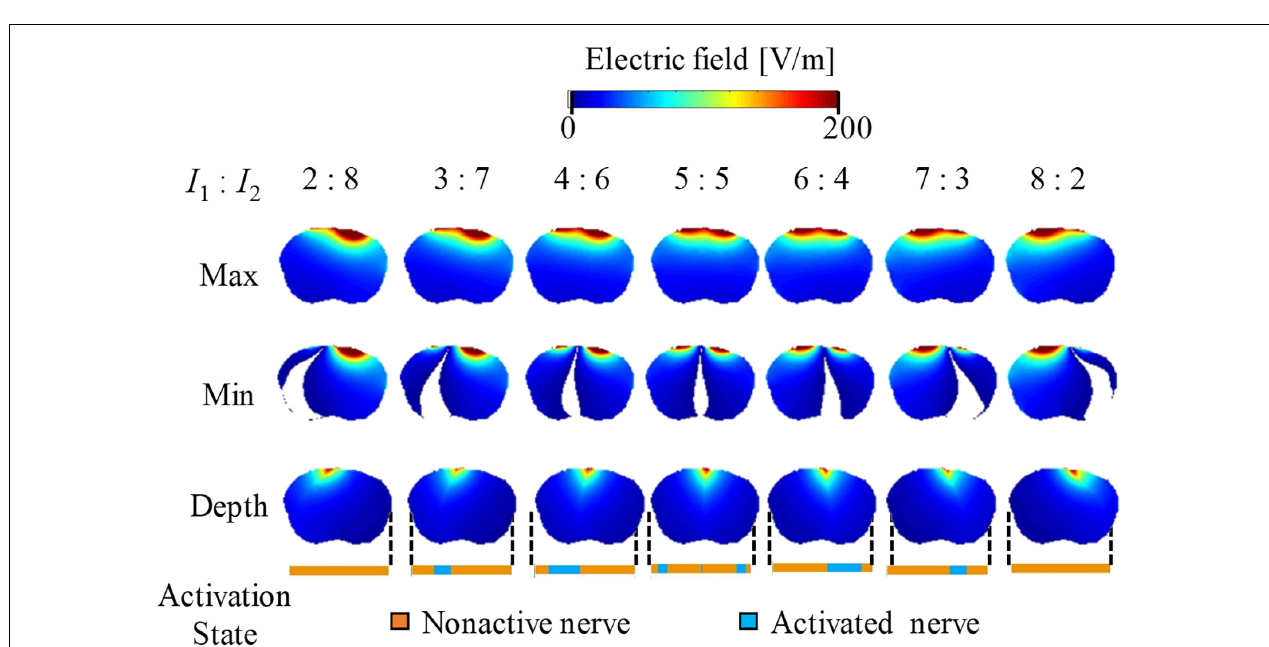
FIGURE 6 | Electric field distribution of the envelope for three metrics: maximum, minimum, and (see definitions in Figure 2 ). Activation state of the axons is indicated.